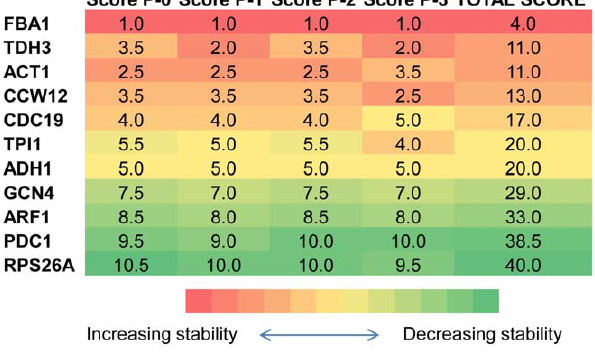
Figure 3. Scoring of the candidate genes in Case Study II. The cells representing the scores of the genes in different pools were colour coded. A coding scale from red to green indicated decreasing stability. The score of the genes in each pool was indicated by the number assigned to that cell in a quantitative manner; the smallest score indicating the most stable gene and the largest score indicating the least stable one. The stability of the gene associated with that score was also indicated by the colour assigned to that cell in a qualitative manner. The scoring of the four different pools of candidate genes was determined as the average ranking for each gene as indicated by the NormFinder and the geNorm analyses and the results were provided in the first six columns. The analysis was carried out using all genes (P-0), and using the 3 pools, each excluding a different set of correlated genes (P-1 to P-3). The total score for each gene was provided in the last column by summing up all of its scores through P-0 to P-3.